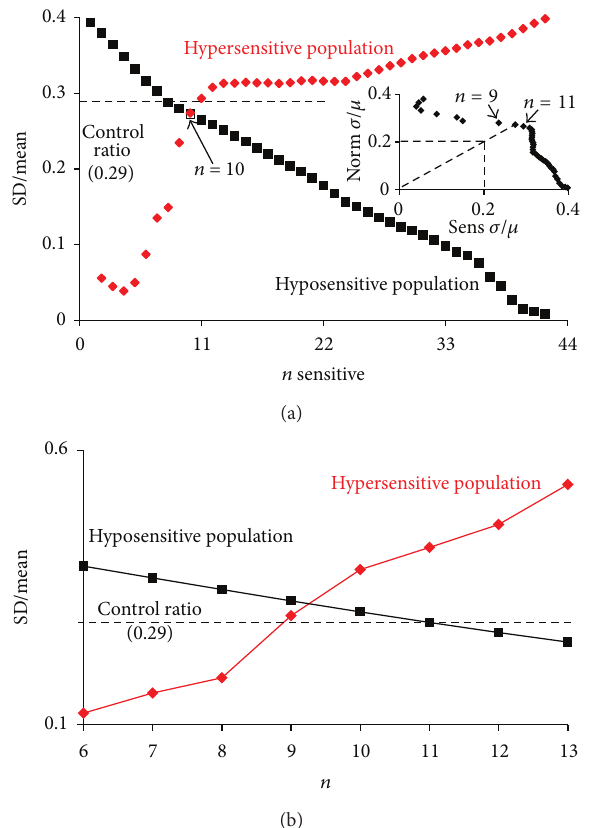
Figure 3: This figure shows two methods to estimate the size of the thimerosal sensitive population, by using a pseudo-Jackknife statistical procedure (a) and by simulation (b). In (a) the ranked data set shown in Figure 2 was treated as a bimodal population. We calculate the mean and standard deviation where the size of the hypersensitive population, n , was increased from 0 to 44 and the bulk population fell from 44 to 0. The ratios of the two SDs divided by their means were plotted against n . The dashed line is the ratio of the SD/mean of the control population. The insert shows the line- shape generated when the two ratios are plotted against each other. This pseudo-Jackknifing procedure indicates that the size of the hypersensitive population is at least 8 and could be as high as 11. The ranked data were also fitted by simulation to two populations with means of ≈ 380 and ≈ 100nM, respectively. The simulations indicated that the two populations had the same population distribution when n was 9,